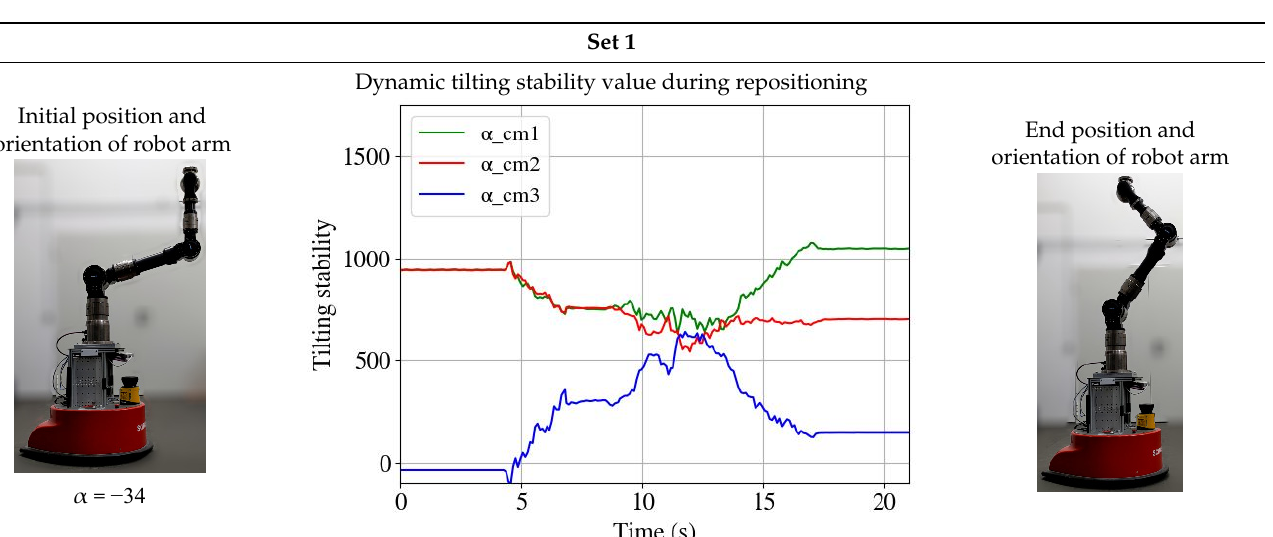
Table 4. Comparative scenarios in order to verify the effectiveness of the active stabilization using the real mobile manipulator.